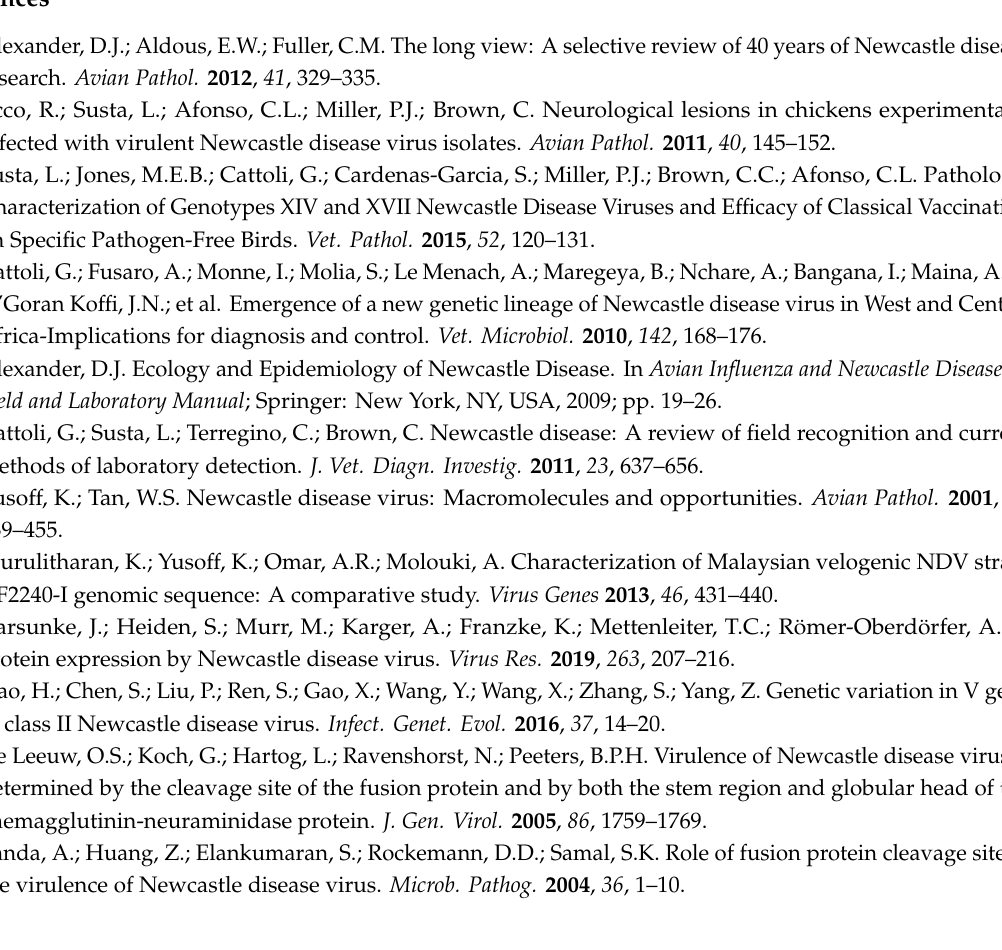
Figure S1: Verification of helper plasmid constructs by (I) colony PCR amplification of NP, P and L and (II) restriction endonuclease digestion of pCIneo-NP, pCIneo-P and pCIneo-L using EcoRI, MluI and